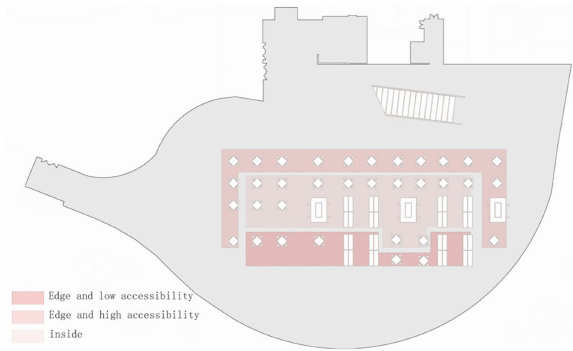
Figure 5. Diagram of privacy partition.